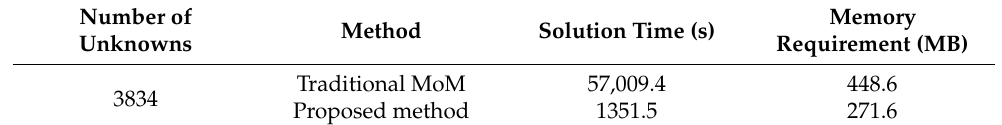
Table 1. Comparison of the computational costs between the proposed method and the traditional MoM for the nanosphere array.